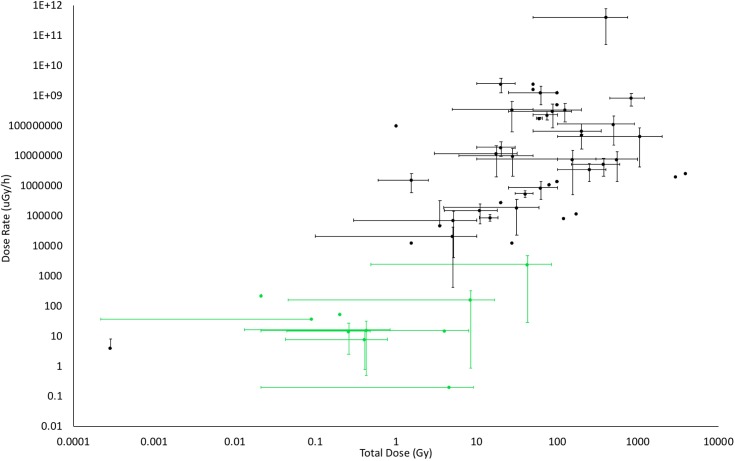
The doses and dose rates used in studies of the effects of IR on plants. Where possible, dose rates and total doses from published studies were determined from methods sections or by calculation of them from details provided. The bars on the points above represent the ranges of dose and/or dose rate used in the published works. Studies in the field are coded in green, those from the laboratory in black. Although not all published studies could be included because doses or dose rates were not provided or could not be calculated, this significant selection of the published data shows that there are few laboratory studies at low doses, especially for chronic exposures (Details of studies are in Supplementary Data Sheet S4).